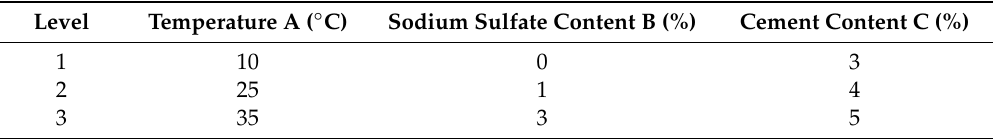
Table 7. Factor levels in orthogonal